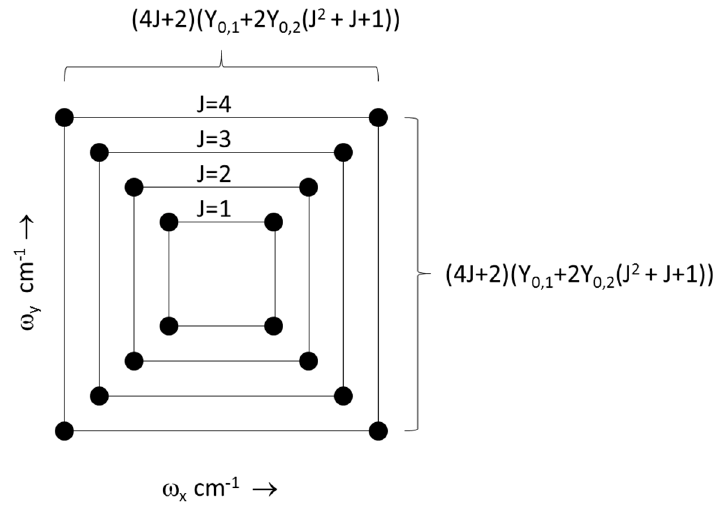
Figure 3. The height and the width of the rectangles in HRC2DS can be used for the method of combination differences. If the frequency on the x axis is different from that on the y axis, then combination differences for two different regions of the spectrum will be recorded simultaneously. Analysis for each axis can be conducted independently, but in the end, the J values should agree for both sets of results.